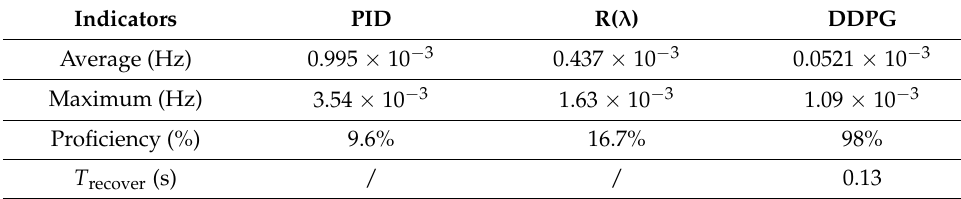
Table 5. Frequency simulation results under load disturbance.